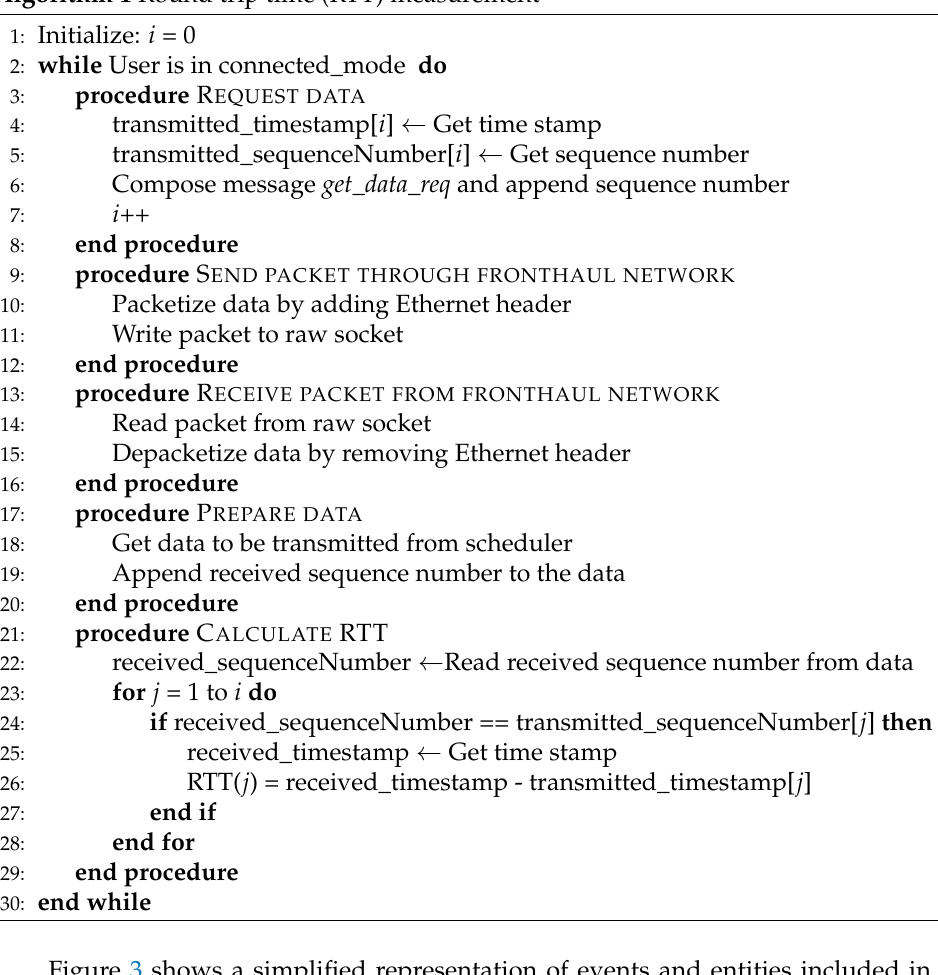
Algorithm 1 Round trip time (RTT)